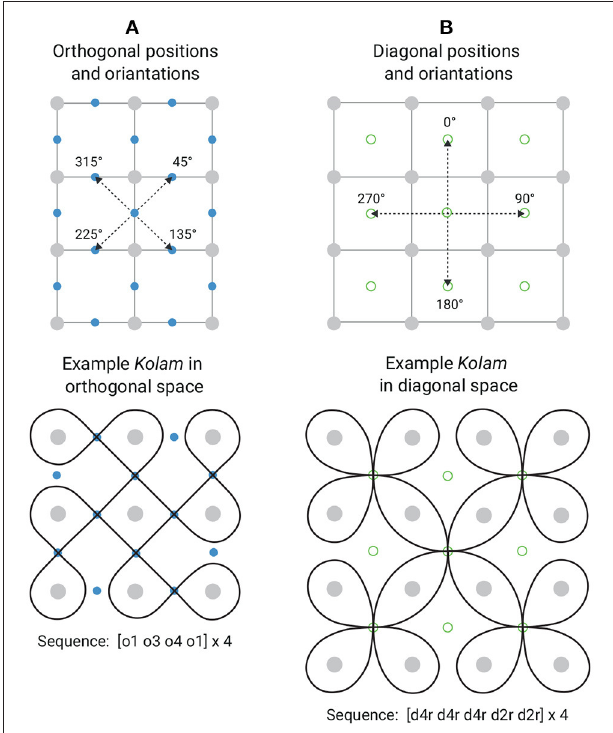
FIGURE 2 | Explanation of the geometric spaces in kolam art. Taken and adapted with permission from Waring (2012b). Panel (A) shows the orthogonal geometric space with an example kolam drawing and Panel (B) shows the diagonal space with an example kolam drawing. In Panel (A) , the dashed arrows illustrate the possible orthogonal starting and ending positions of gestures (blue dots) and loops as well as the orthogonal orientations of gestures: 45 ◦ , 135 ◦ , 225 ◦ , 315 ◦ angles. In (B) , the dashed arrows illustrate the possible diagonal starting and ending positions of gestures (green circles) and loops as well as the diagonal orientations of gestures: 0 ◦ , 90 ◦ , 180 ◦ , 270 ◦ angles. Sequence: The sequence of gestures that the specific kolam designs can be decomposed into (see lexicon in Figure 1